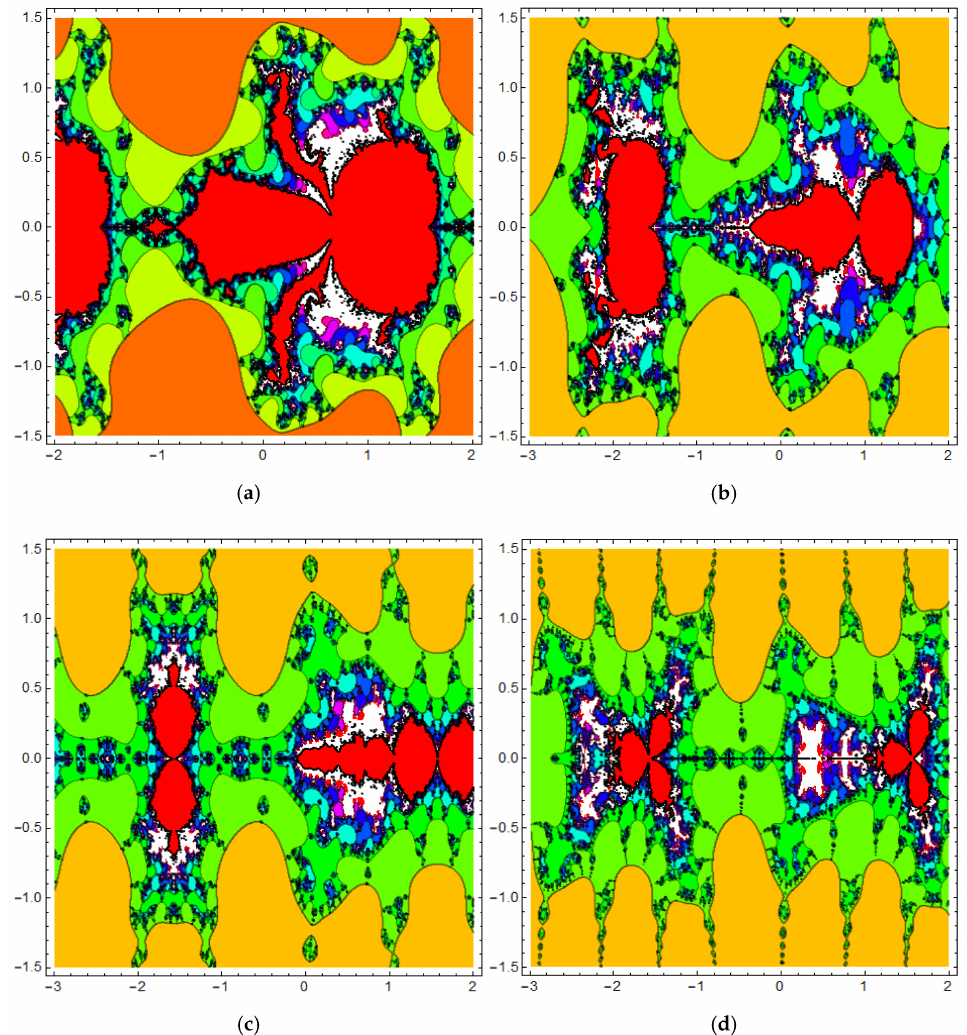
Figure 3. The Mandelbrot sets generated by the generalized fractional cosine map at α = 0.9, where